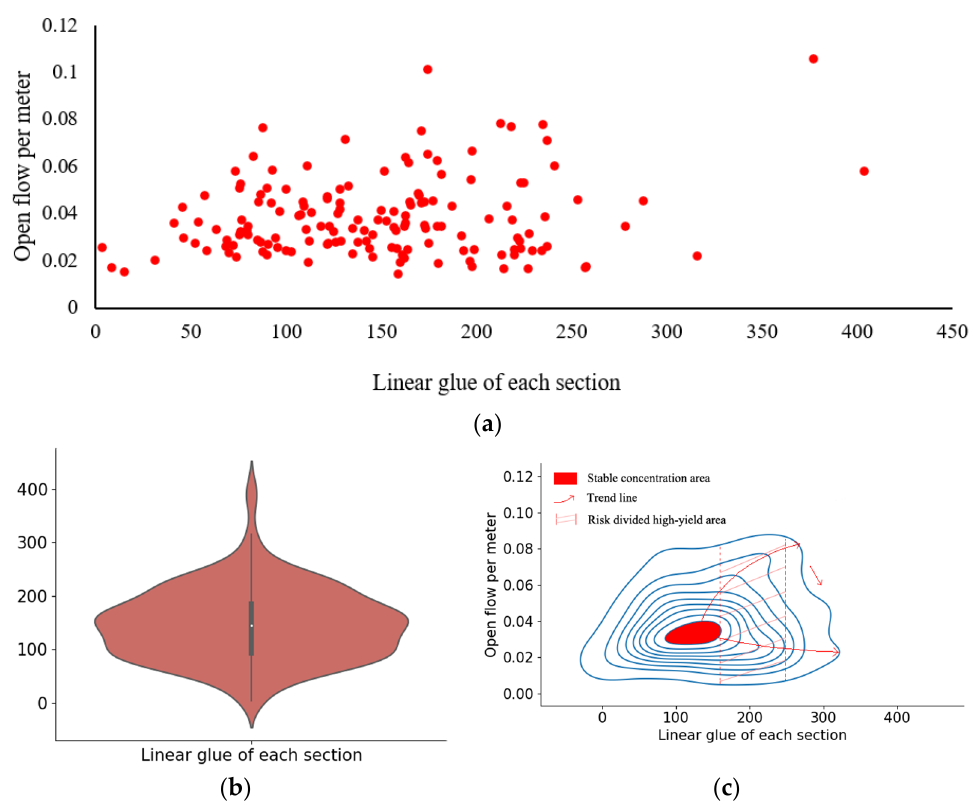
Figure 6. Analysis of linear glue data. ( a ) Scatter plot of linear glue; ( b ) violin plot of linear glue; ( c ) binary KDE plot of linear glue.